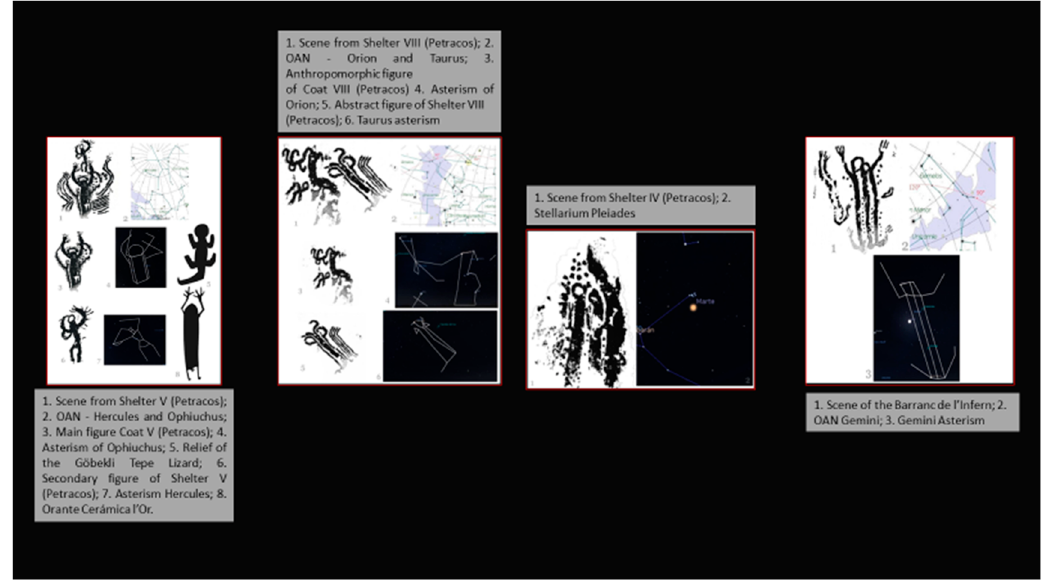
Figure 24. The paintings of Pla de Petracos and the constellations. Fountain: (Urbano et al. 2020, pp. 159–63).